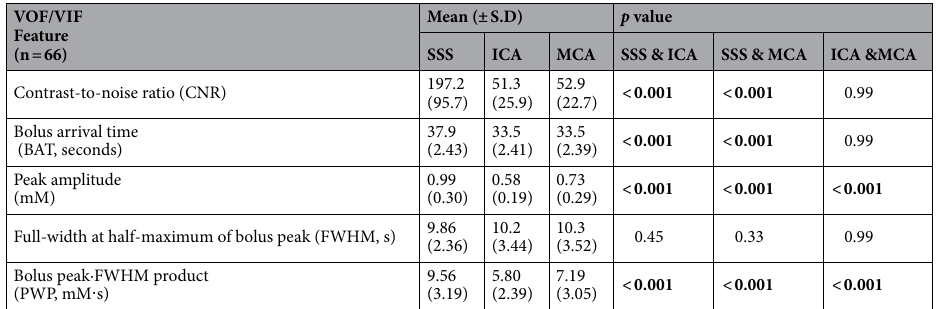
Table 1. Comparison of semi-quantitative VOF/VIF features extracted from superior sagittal sinus (SSS), internal carotid artery syphon (ICA) and middle cerebral artery (MCA). Significant values are in [bold]. Mean (± S.D) of each semi-quantitative parameter shown. Extracted semi-quantitative parameters were compared using a repeated-measures ANOVA with Greenhouse–Geisser correction for non-sphericity. Post hoc analysis of pairwise comparisons between different timepoints was performed using the Bonferroni method. P value shows comparison between each VIF location (SSS, ICA, MCA). BAT Bolus arrival time, ICA Internal carotid artery, MCA Middle cerebral artery, PWP Bolus peak∙FWHM product, SSS Superior sagittal sinus, VIF Vascular input function, VOF Vascular output function.